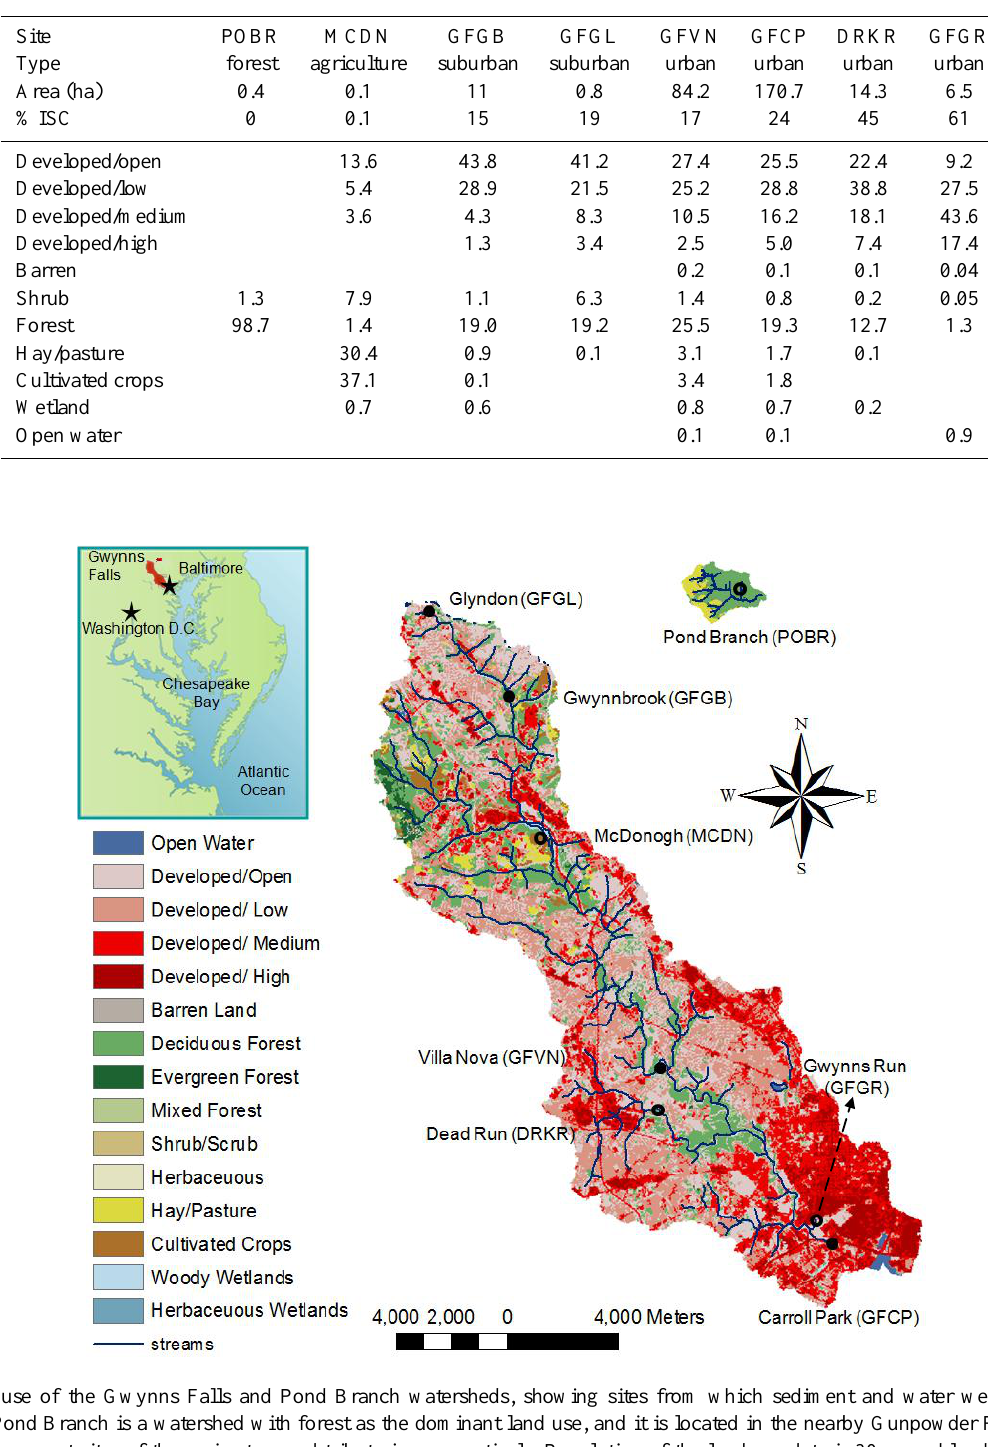
Table 1. Characteristics of study subwatersheds.Watershed land cover and impervious surface (ISC%) data are from Shields et al. (2008) and the National Land Cover Database (NLCD). Both land cover and impervious statistics were based on 30-m resolution land cover data.